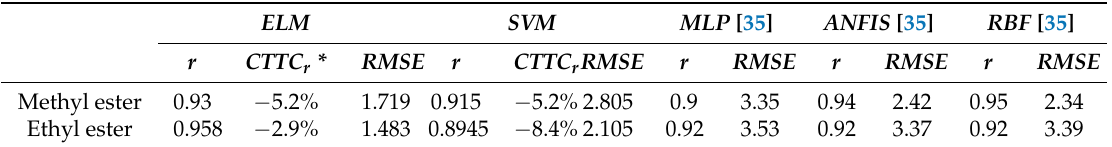
Table 6. The results of the testing stage for both ELM and SVM